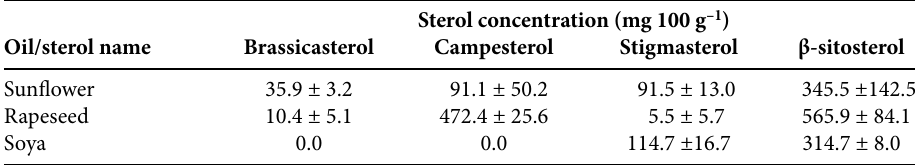
Table 5. Sterol content in sunflower, rapeseed and soya oils used for